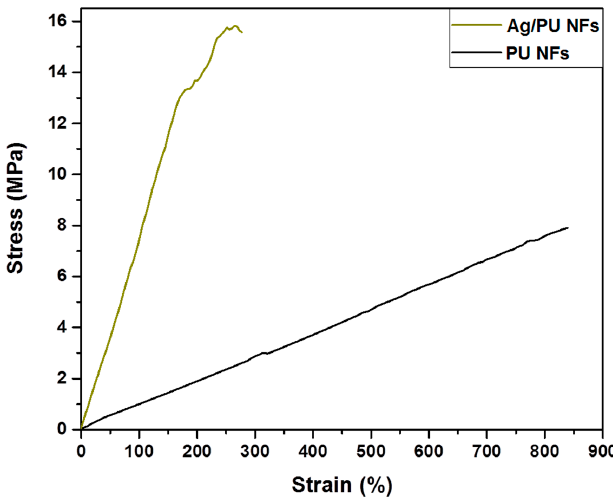
Figure 6. Representative stress–strain curves of the PU and Ag/PU NF mats.